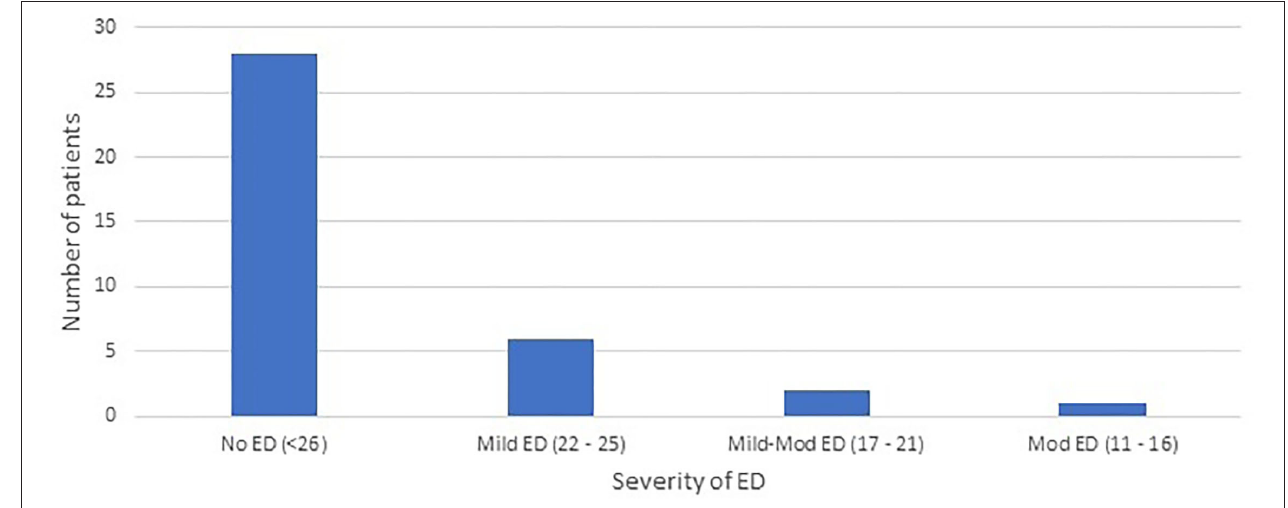
FIGURE 2 | Number of patients with, and severity of erectile dysfunction (ED) via the International Index of Erectile Function.